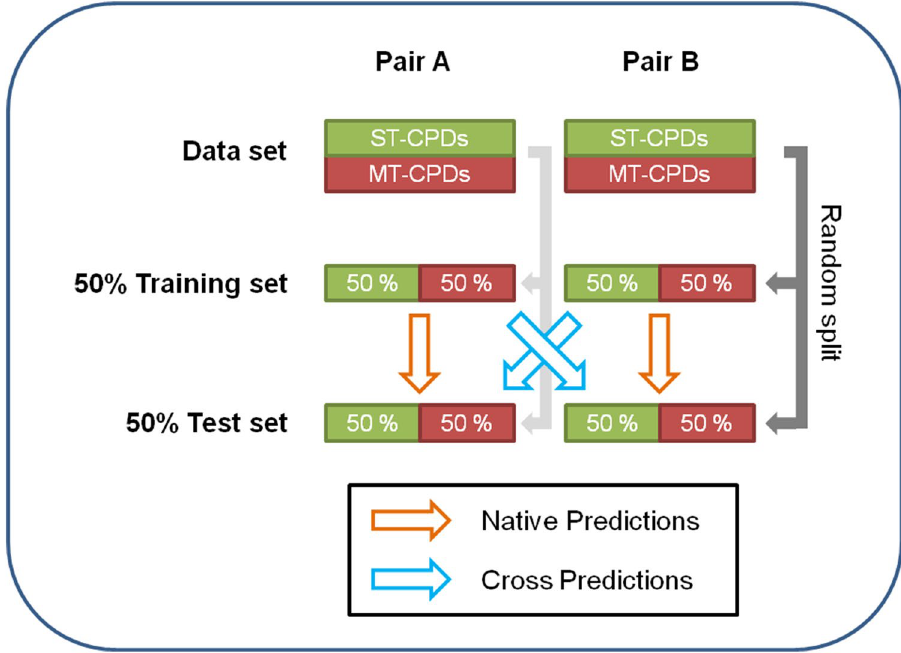
to predict test sets of the same target pair (native prediction) and different target pairs for which the model was not derived (cross predictions). In each case, this procedure was repeated 10 times with test and training sets of different